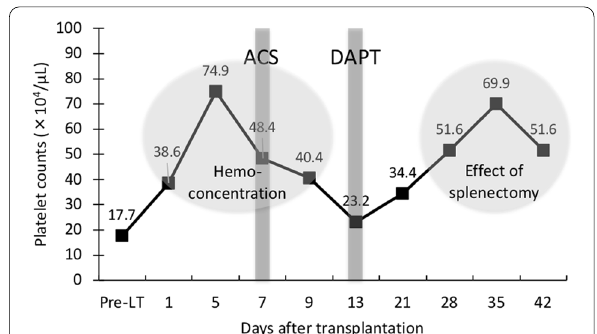
Fig. 5 Chronological change in platelet counts. LT liver transplantation; ACS, acute coronary syndrome; DAPT dual antiplatelet